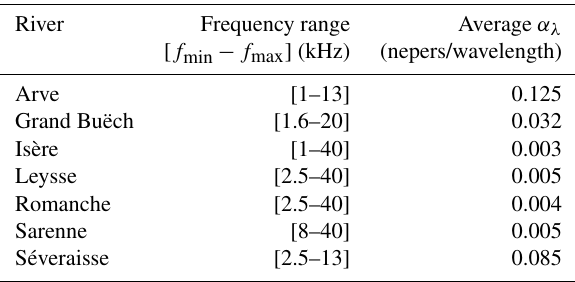
Figure 9. Attenuation coefficient per wavelength (nepers) as a func- tion of frequency (Hz) above the cutoff frequency. Table 3. Frequency bands where α λ was observed to be almost constant with frequency and average values of α λ in this frequency